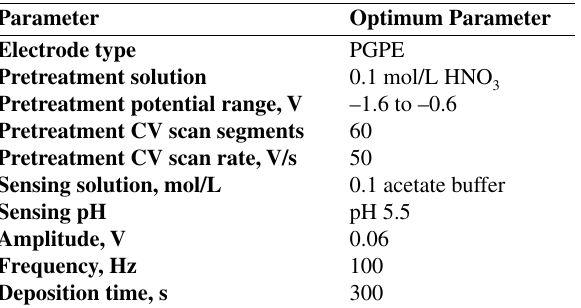
Table 1: Optimal parameters for Hg(II) determination by the SWASV method using